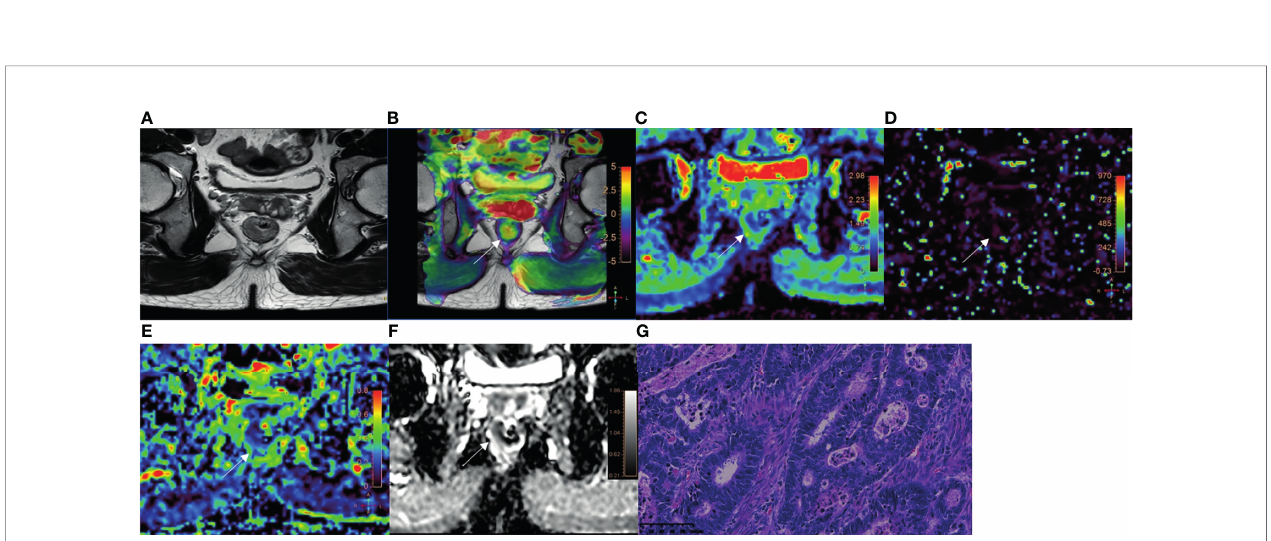
FIGURE 3 | A 52-year-old male with AC of grade 2. (A) Oblique axial T 2 -weighted image showed a mass with slightly high intensity in the rectum. (B) APT-T2 merged image showed the mass with a mean APT SI of 2.1%. (C – E) D, D* and f maps showed the mass with values of 0.81×10 -3 mm 2 /s, 7.74×10 -3 mm 2 /s and 0.19, respectively. (F) The mass showed low intensity (1.03×10 -3 mm 2 /s) on the ADC map. (G) HE staining revealed moderately differentiated adenocarcinoma.